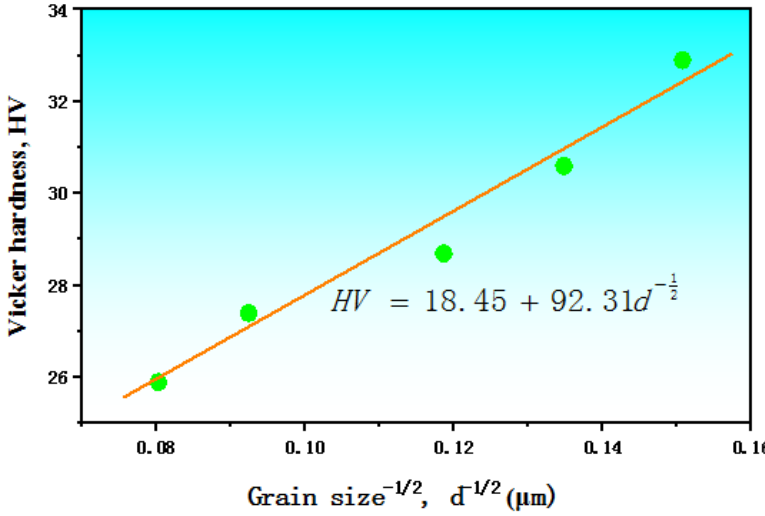
Figure 3. The relation between the Vickers hardness (HV) and the average ferrite size ( d ).